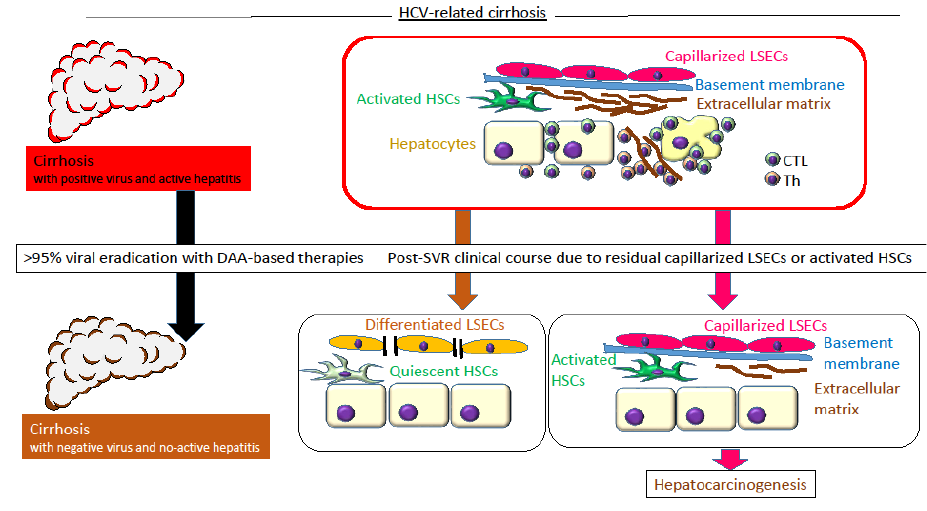
Figure 1. A conceptual diagram of probable post-sustained virologic response (SVR) hepatocarcinogenesis in hepatitis C virus (HCV)-related cirrhosis.